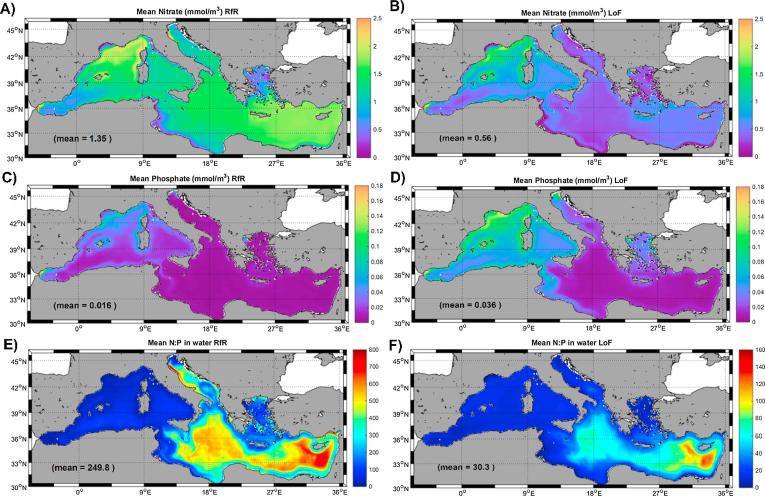
Mean climatological free nitrate and phosphate concentrations in seawater (0–10 m) for the RfR simulation (left column) and for the LoF simulation (right column). The climatological N:P ratio in water for each simulation are shown in the bottom panels. Inserted in each panel there is the mean, basin-wide integrated value of each represented variable. Please note the different color scales in panels E) and F). (For interpretation of the references to colour in this figure legend, the reader is referred to the web version of this article.)